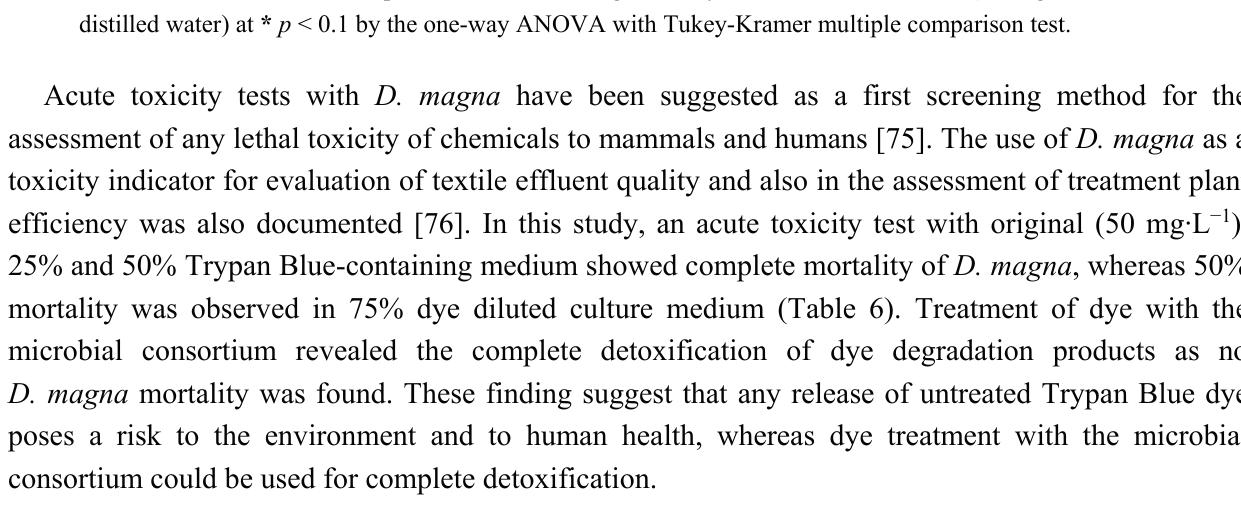
Table 6. Mortality of D. magna exposed to 75% dilution of the culture supernatants containing Trypan Blue treated with microbial